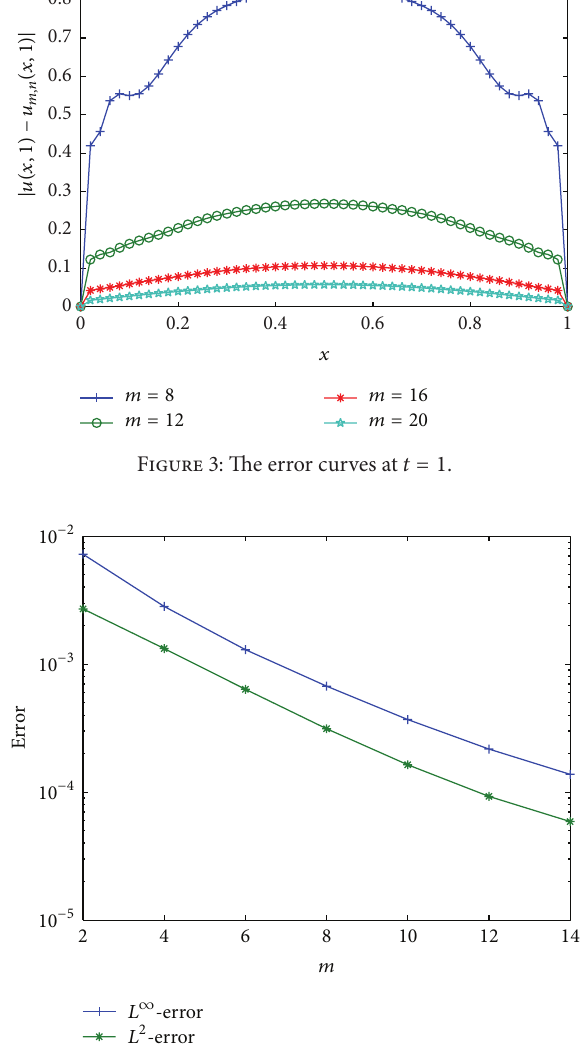
Figure 4: 𝐿 2 - and 𝐿 ∞ -errors versus 𝑚 .